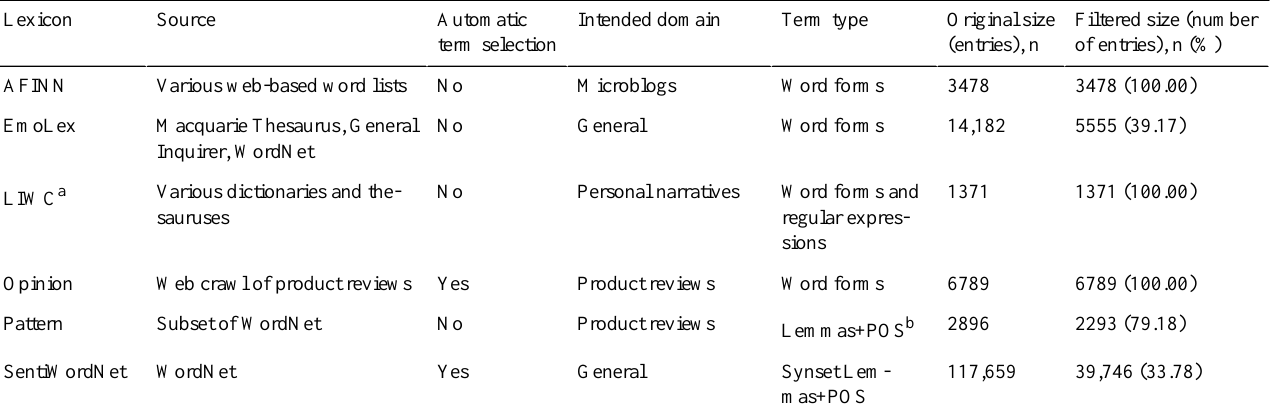
Table 3. Characteristics of the 6 sentiment